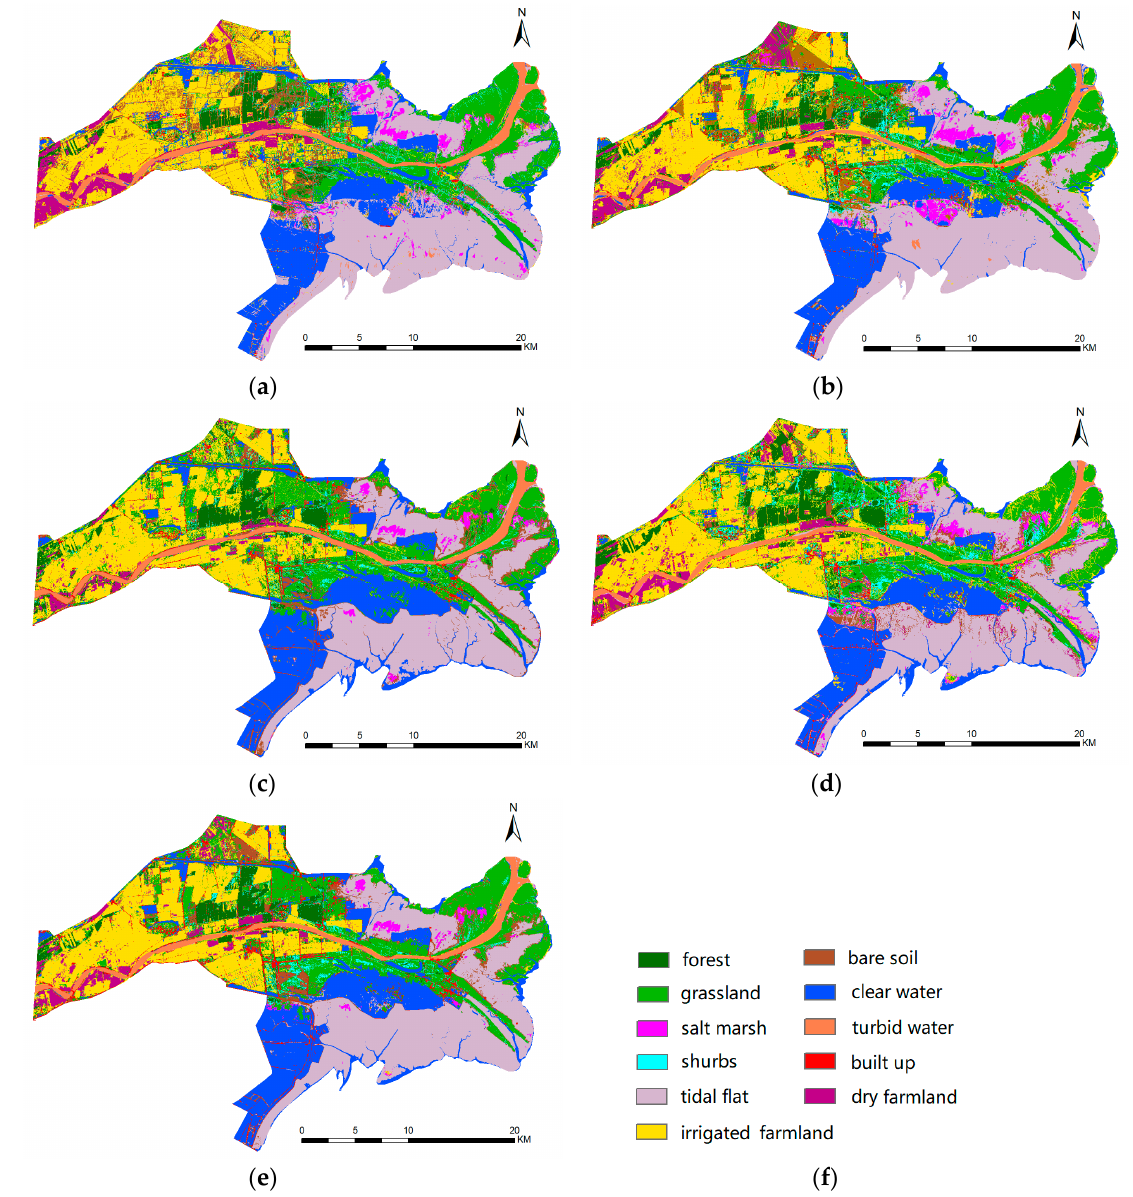
Figure 11. Classification results for ( a ) T1/2018-04; ( b ) T2/2018-06; ( c ) T3/2018-08; ( d ) T4/2018-10; and ( e ) multitemporal; ( f ) legend. Table 6. Accuracy comparison between mono- and multitemporal